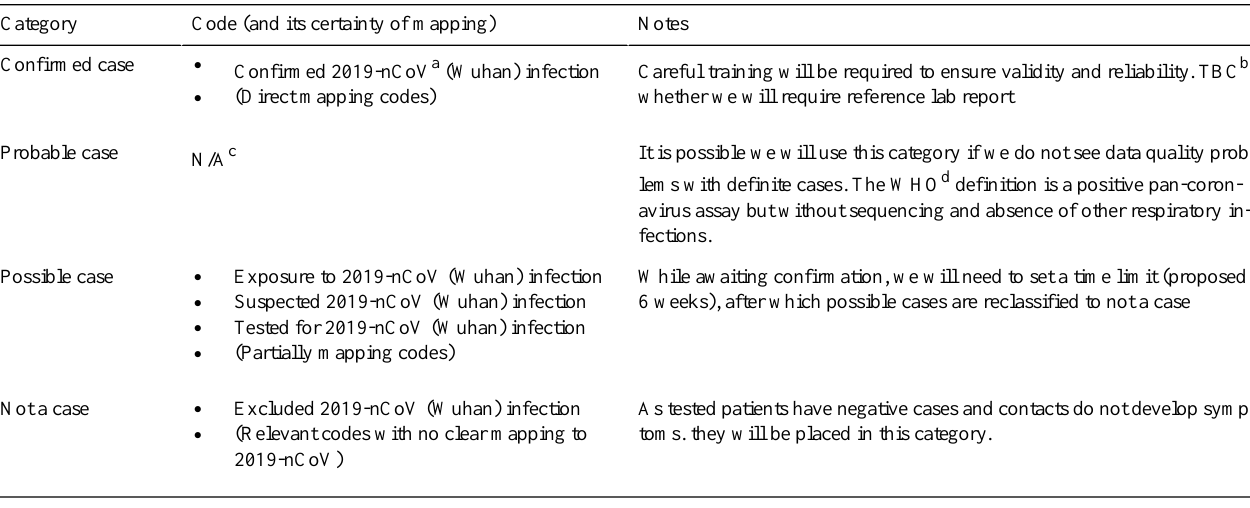
Table 5. Ontological approach to mapping COVID-19